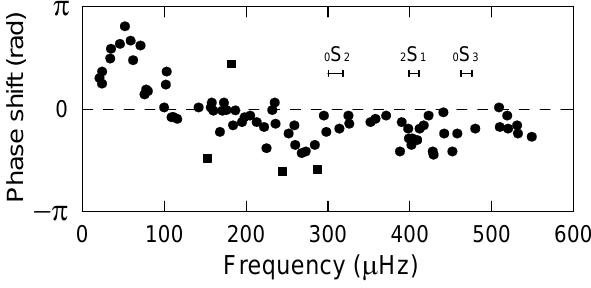
Fig.11 Fig. 11. Phase shift between oscillations, detected simultaneously by microbarometer and seismometer measurements, as a function of frequency (circles). The phase shifts which certainly are not in agreement with characteristic ones are represented by squares. The frequency ranges of the Earth free spheroidal oscillations which are split into components (Rosat et al., 2005) are marked by